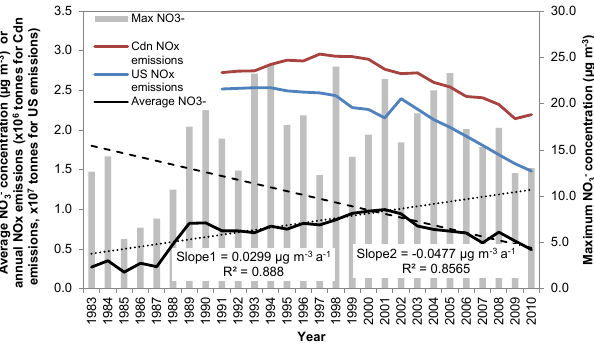
Figure 3. Temporal trends of annual atmospheric NO − NO x emissions. Slope 1 refers to the regression line for NO − tween 1991 and 2001 (positive trend, 3.6% increase), while Slope 2 is for the period between 2001 and 2010 (negative trend, 6.5% de- crease). Between 1991 and 1997, NO x emissions in Canada (Cdn) increased by 8.5%. Between 1997 and 2010, Cdn NO x emissions decreased by